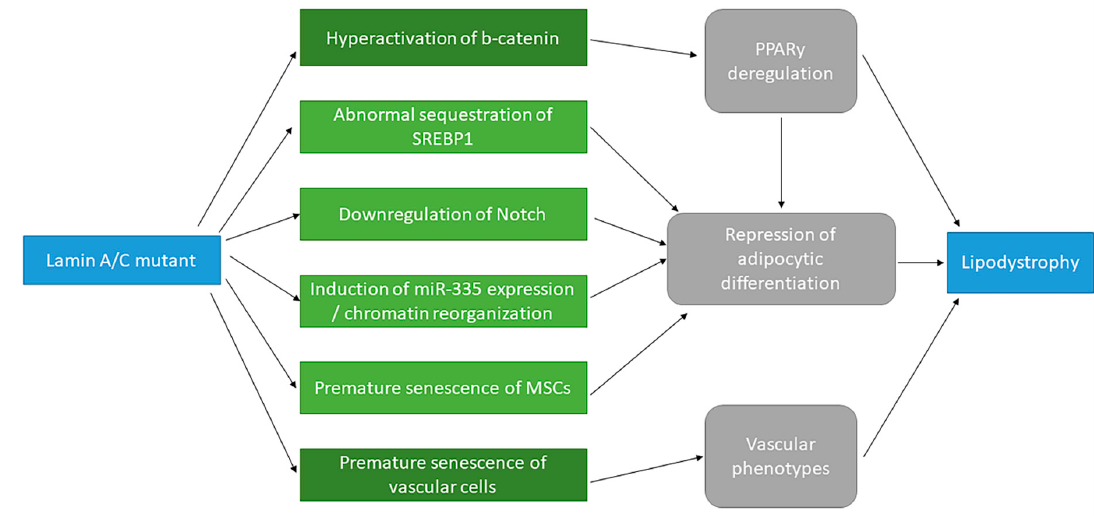
Figure 1. Summary scheme of the different signaling pathways affected by LMNA mutations associated with the physiopathology of familial partial lipodystrophy type 2 (FPLD2).